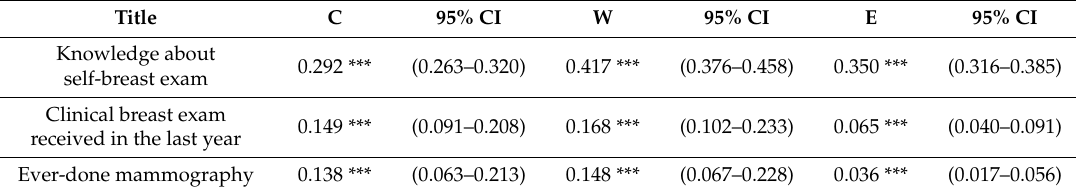
Table 4. Inequality indices in uptake of breast cancer screening by